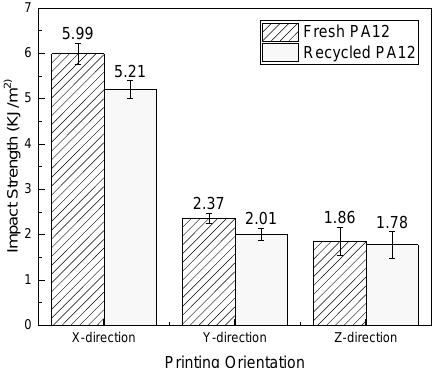
Figure 6. Impact strength of test samples in different printing orientations.